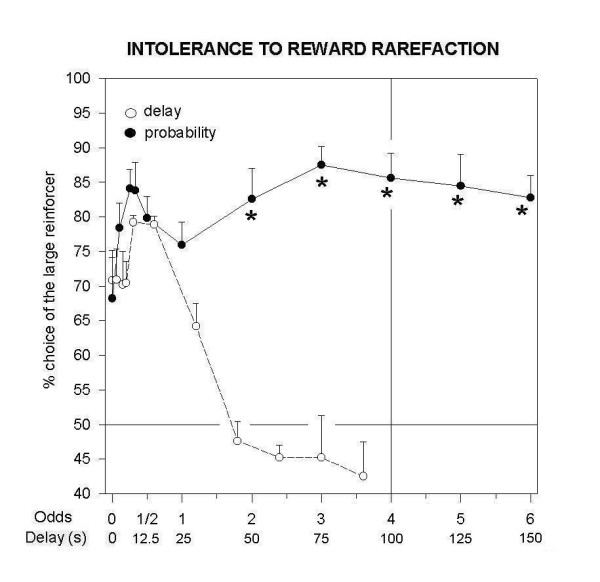
Choice behavior in rats (n = 8) tested with either ID or PD protocols. Data are the same as shown in Figure 2, but the ID-task curve has been scaled according to the a posteriori re-estimation of equivalence between odds/probability and delay (see also Table 1). The asterisks denote daily sessions at which points of the PD tasks were significantly different from the corresponding points of the ID task. It is clearly evident that the delay dimension produced aversion for LL, whereas the probabilistic dimension produced a preference for LLL.